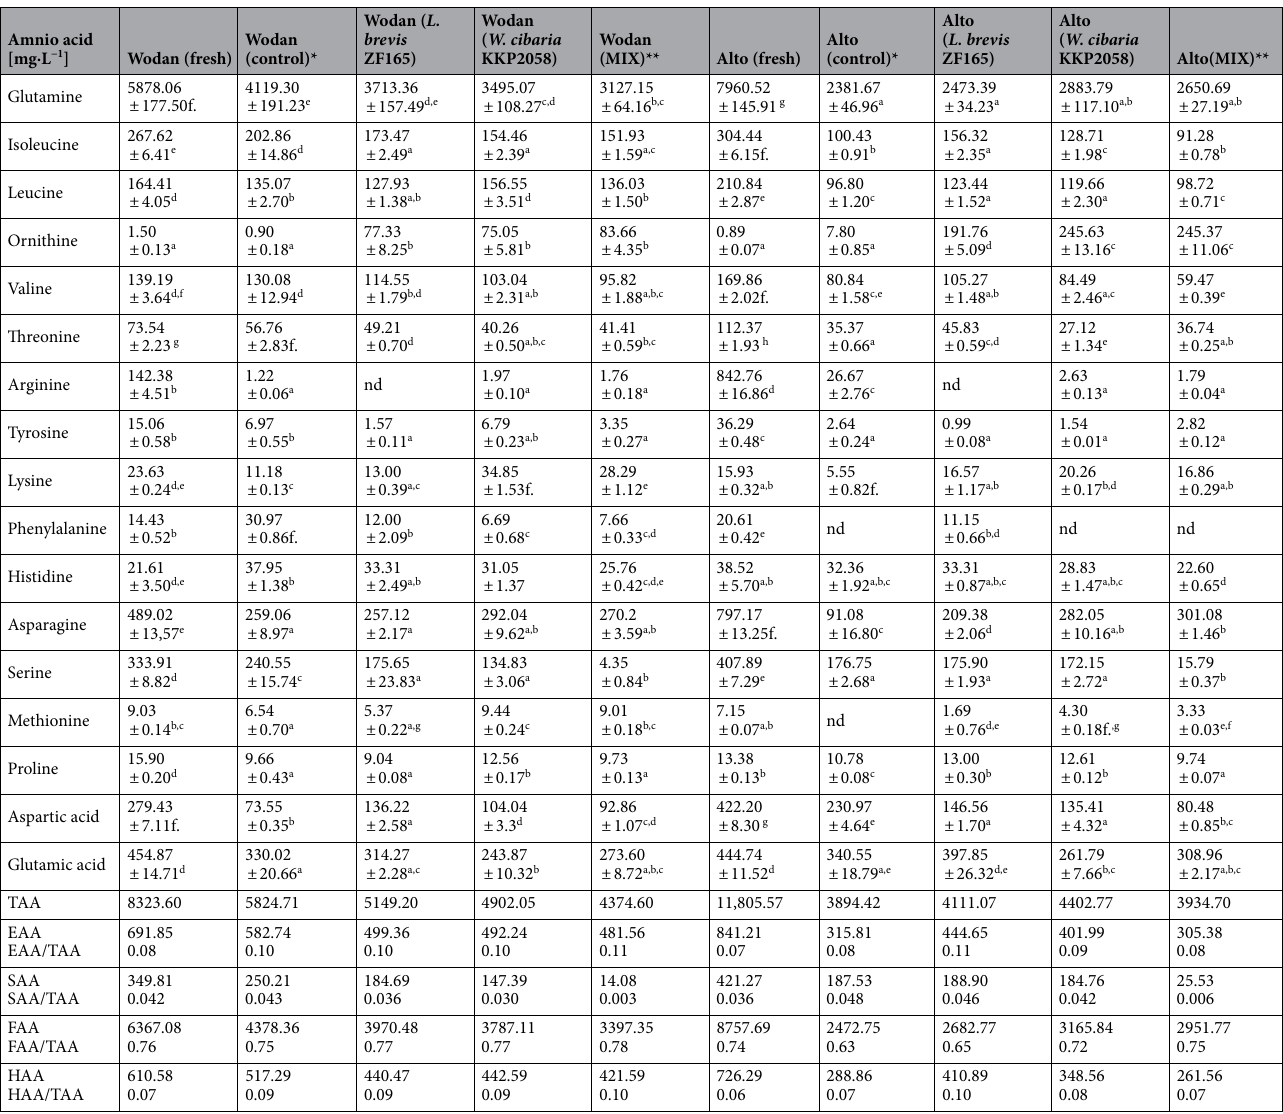
Table 3. Content of free amino acids in the fresh and fermented red beet juices of Wodan and Alto variety. *Control: spontaneous fermentation. **MIX: L. brevis ZF165; W. cibaria KKP2058; L. plantarum KKP1822; L. fermentum KKP1820; Leuconostoc mesenteroides JEIIF. nd-not detected. TAA-total amino acid; EAA- essential amino acids (sum of valine, methionine, phenylalanine, isoleucine, leucine, lysine, and threonine); SAA- sweet amino acid (sum of serine and proline); FAA- flavor amino acid (sum of glutamine and asparagine); HAA- hydrophobic amino acid (sum of proline, valine, methionine, phenylalanine, isoleucine, and leucine). Different letters indicate significant differences among the mean values according to the least significant difference test ( P ≤